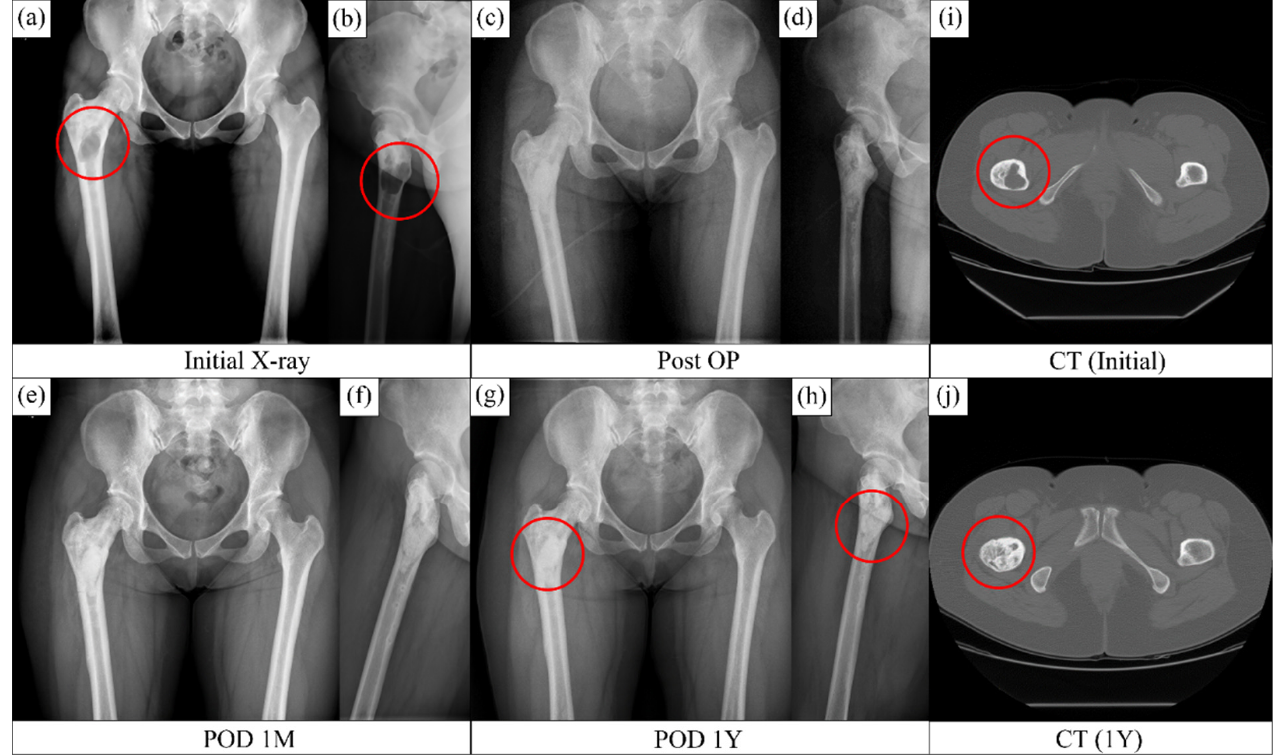
Figure 4. Bone regeneration in the bone void due to the osteofibrous dysplasia. ( a , b ) Preop condition, ( c , d ) postop condition, ( e , f ) after one month of operation and ( g , h ) after 12 months of operation. CT images of the ( i ) tissue lesion of the dysplasia before operation and ( j ) regenerated bone after 12 months postop. The red circles indicate implanted defect zone.